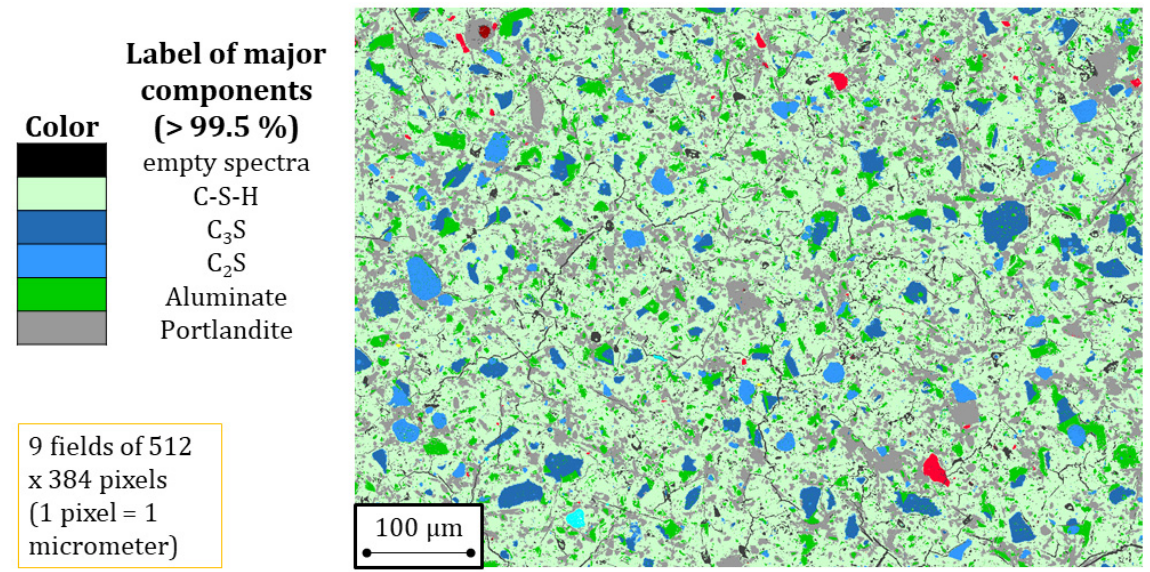
Figure 1. Schematic visualization of PARC results.